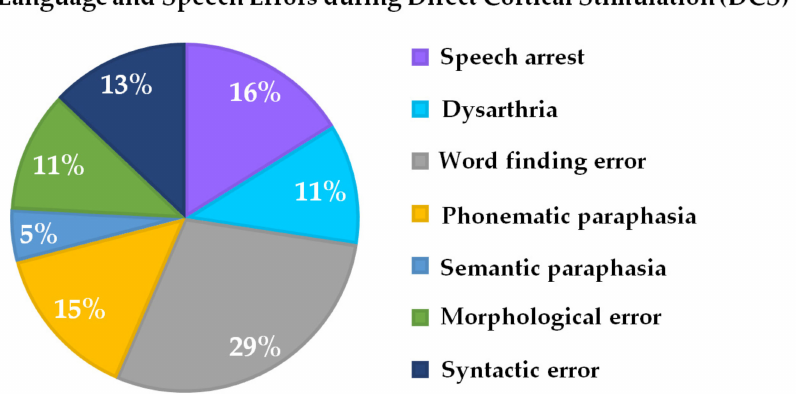
Figure 3. Percentage of intraoperative language and speech errors during DCS associated with the novel language paradigm (see Figure 1).